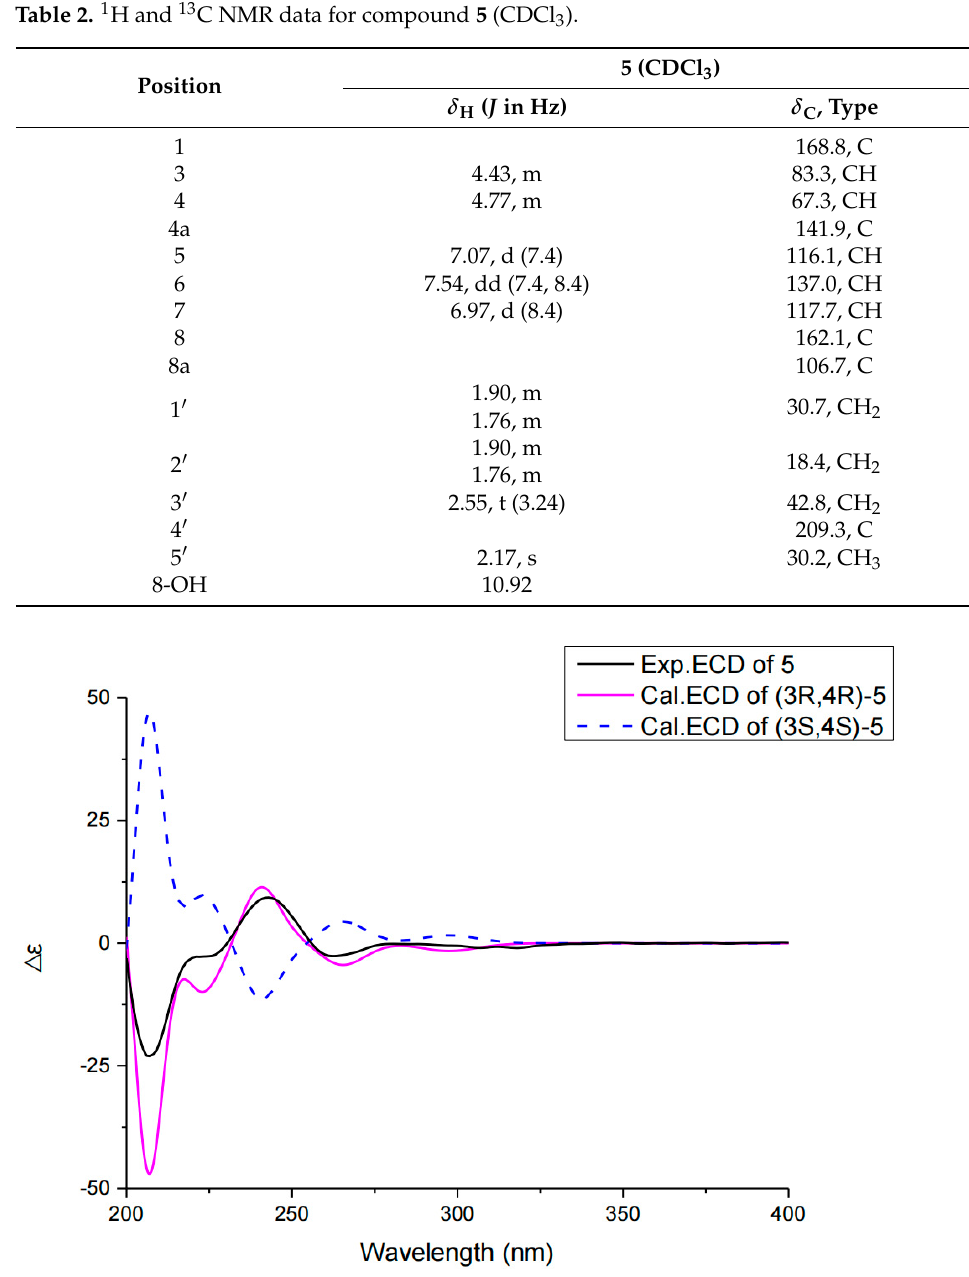
Figure 5. ECD spectra of compound 5 in CH 3 OH.